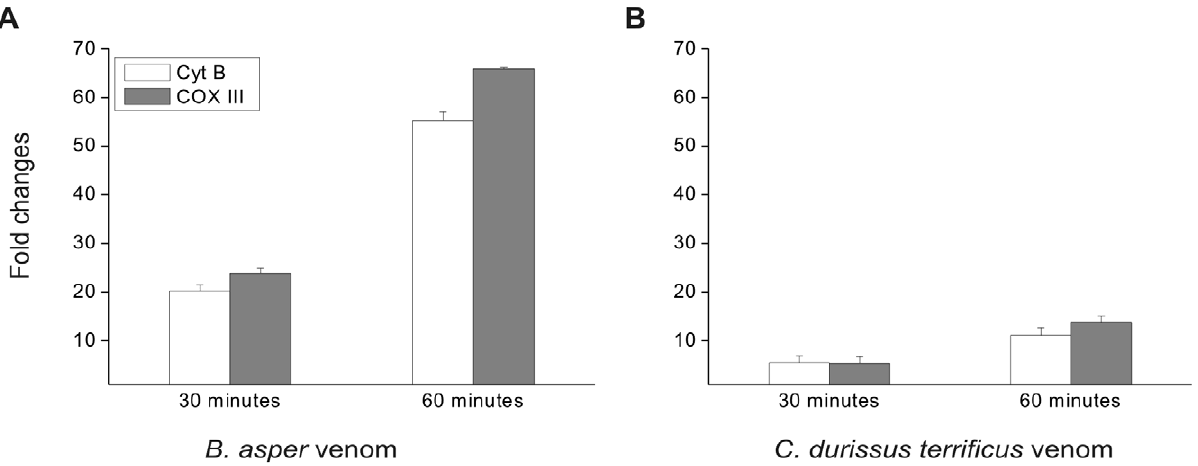
Figure 1. B.asper and C.durissusterrificus venoms induce the release of mtDNA. mtDNA released after ex vivo treatment (as described in Material and methods section) with snake venoms was determined by qPCR, using vehicle treated mice muscles as controls. Mean 6 SD fold changes (treated samples/controls) in DNA coding for Cyt B and COX III relative to isolated tibials anterior mice muscles treated with (A) 50 m g/ml B. asper venom (BaV) or with (B) 50 m g/ml C. durissus terrificus venom (CdV) for 30 9 and 60 9 at 37 u C in oxygenated physiological solution. Data represent the means of 6 independent experiments.